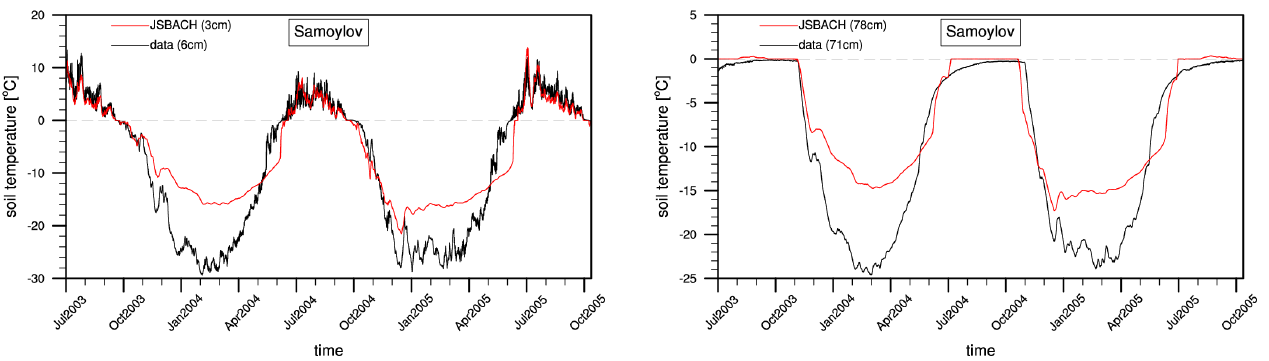
Fig. 4. Observed and simulated upper-layer soil temperature at the Samoylov site. Observed soil temperature at 6cm is plotted with the black line and the red line shows the JSBACH-simulated soil temperature in the first layer (ca. 3cm).